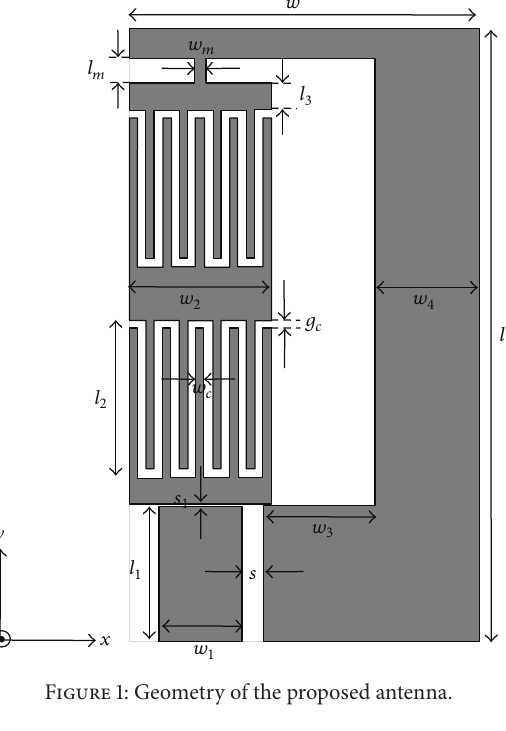
Figure 1: Geometry of the proposed antenna.